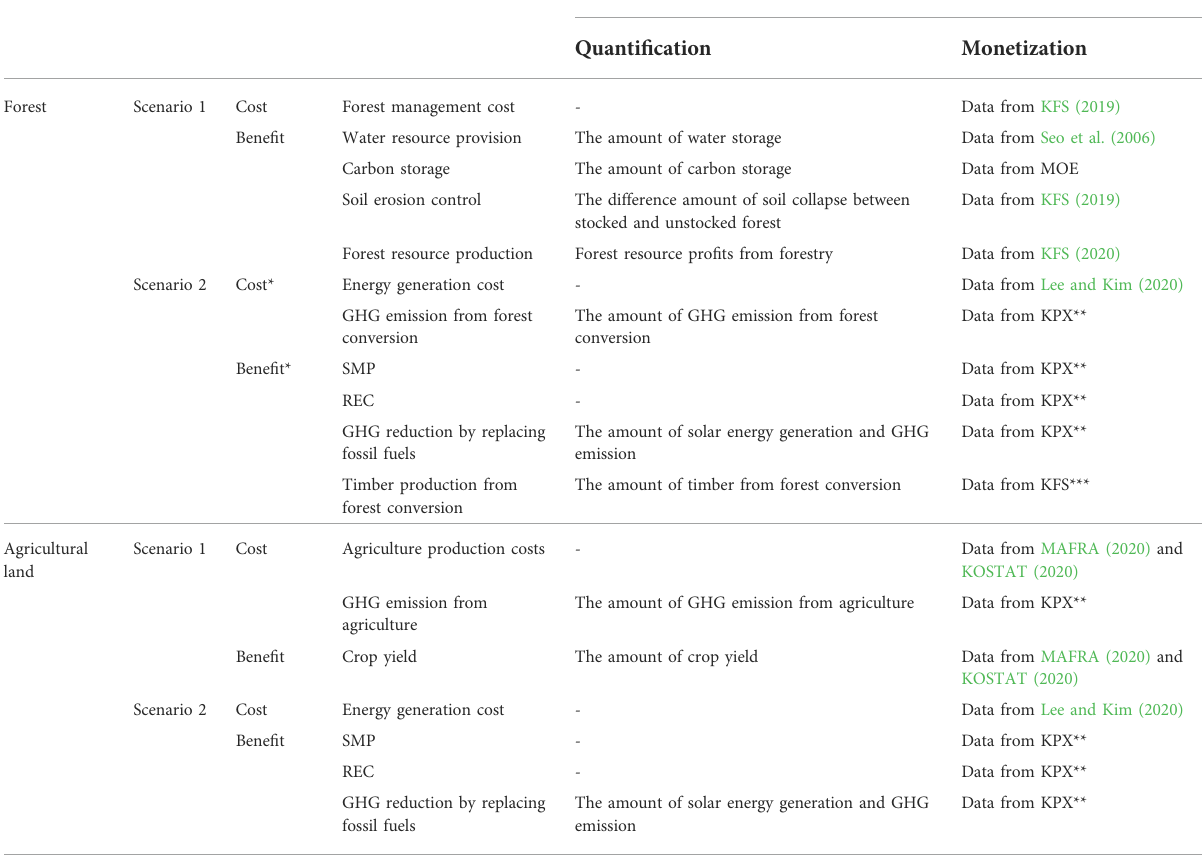
TABLE 1 The factors and methods of NPV assessment in forest and agricultural